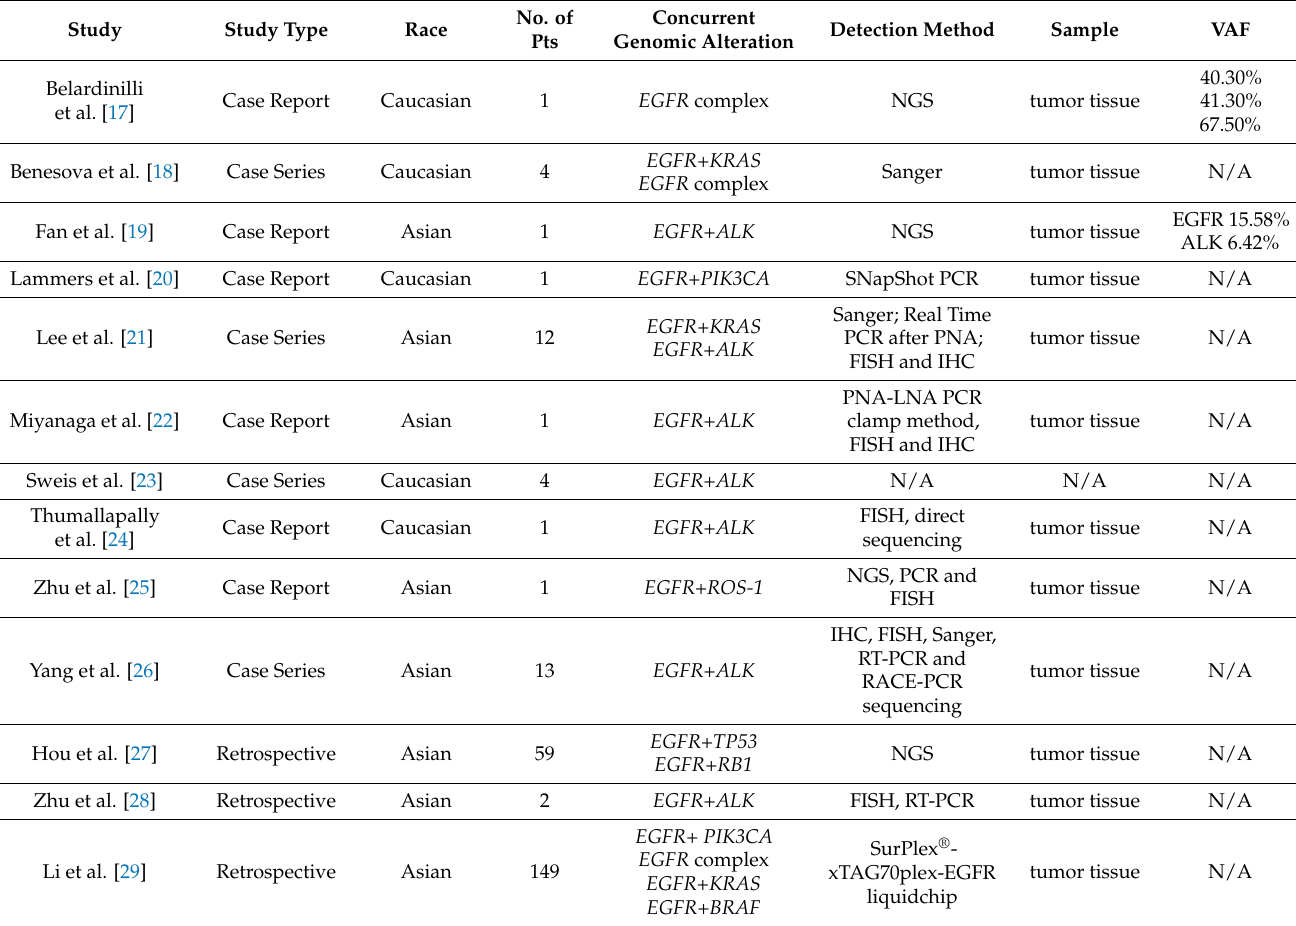
Table 1. Summary of reported demographic characteristics of EGFR -positive NSCLC patients with concomitant genomic